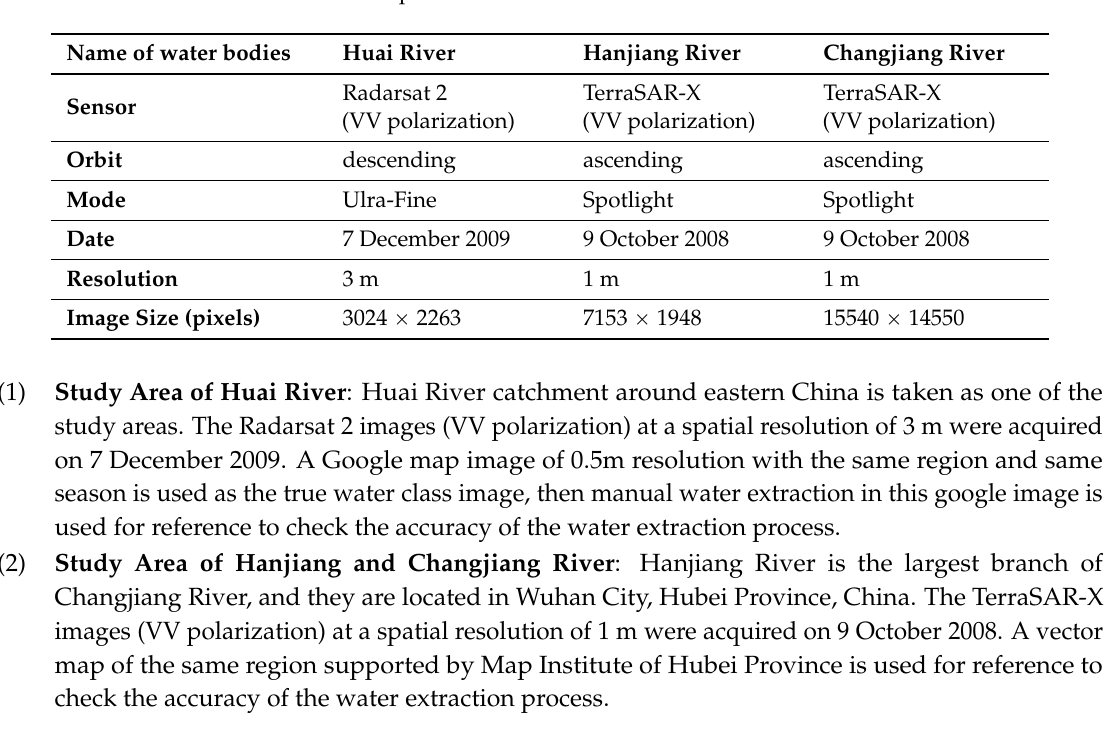
Table 1. Experimental data of different water bodies.